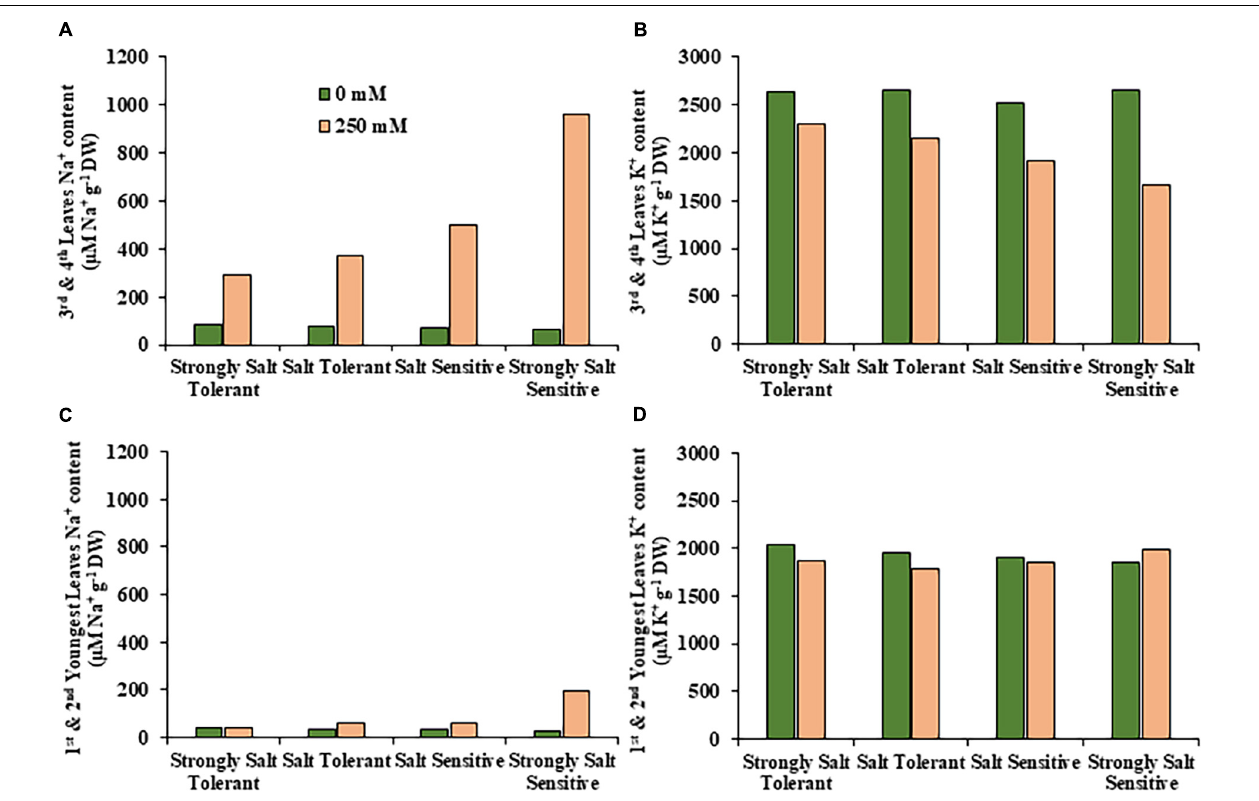
FIGURE 6 | Average sodium and potassium content in leaves for salt tolerant and salt sensitive safflower genotypes under control and salt (NaCl) treatments. Sodium content of significantly salt tolerant, salt tolerant, salt sensitive and significantly salt sensitive genotypes for (A) third and fourth leaves and (C) first and second youngest expanded leaves under control (0 mM; green) and salt (250 mM, pink) treatments. Potassium content of strongly salt tolerant, salt tolerant, salt sensitive, and strongly salt sensitive genotypes for (B) third and fourth leaves and (D) first and second youngest expanded leaves under control (0 mM; green) and salt (250 mM, pink)